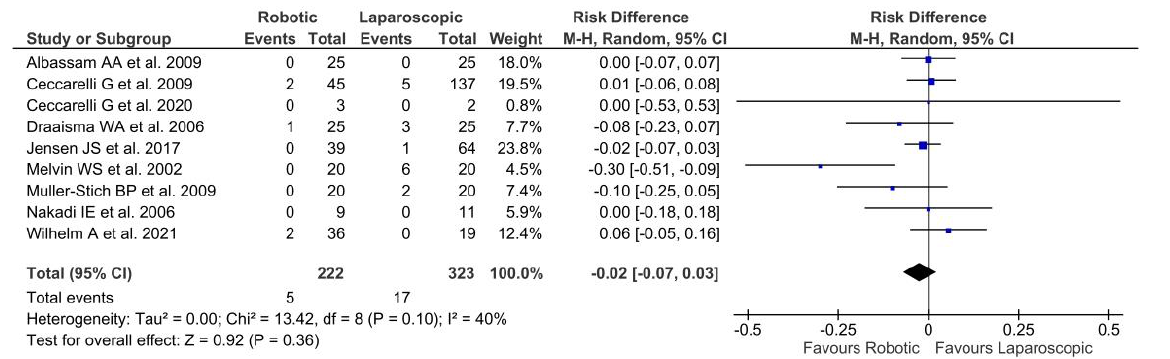
Figure 6. Forest plot of laparoscopic vs. robotic recurrence of reflux symptoms